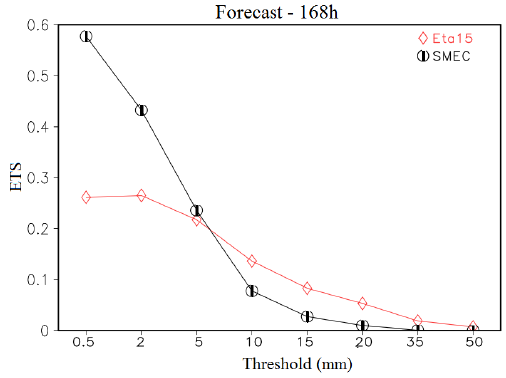
Figure 7. Equitable threat scores (ETSs) to 168h